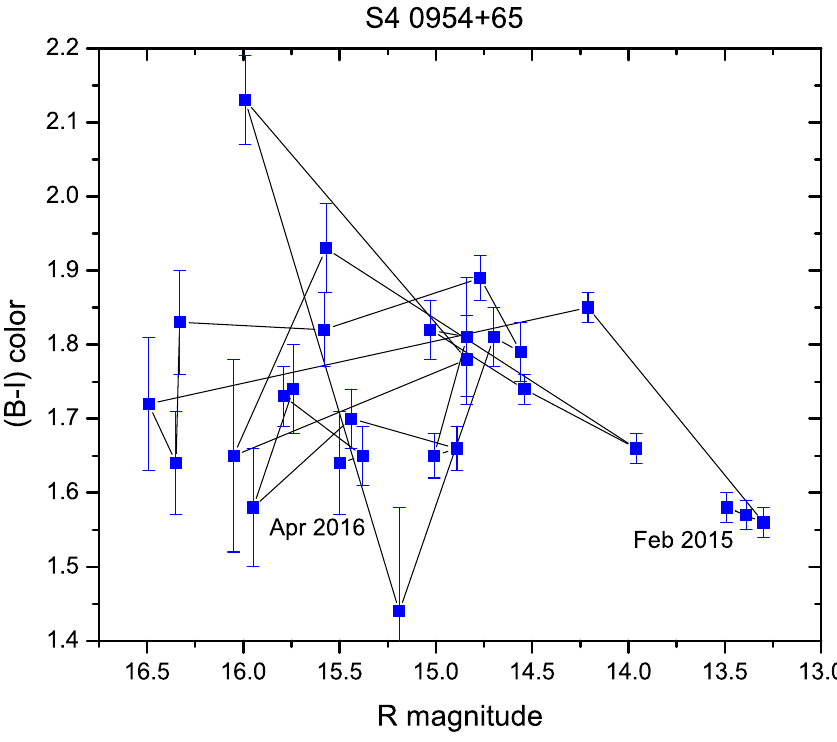
Figure 2. Color (B-I) index for the observed period as a function of the R-band magnitude. No clear systematic behavior can be traced, making color changes to appear random to a large